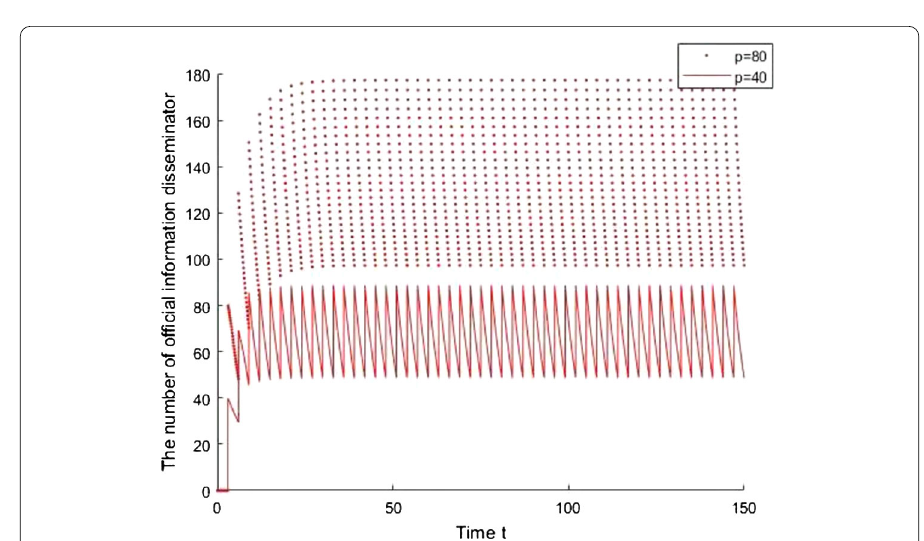
Figure 5 When p > p thr , the evolution graph with different p of y ( t ) are in